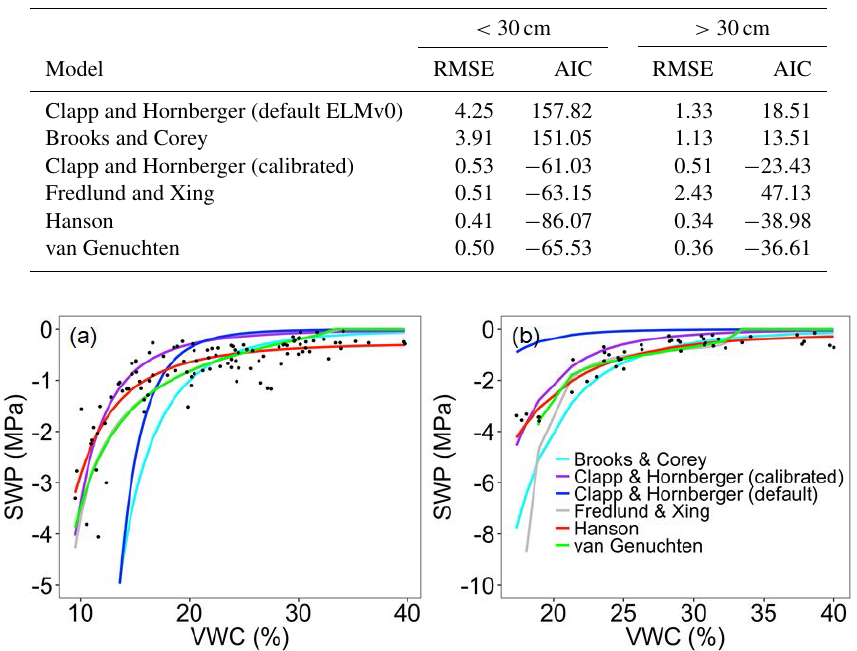
Figure 1. Observed (black dots) and simulated relationship between soil water potential (SWP) and volumetric water content (VWC) by the different models at two soil layers: (a) 0 to 30cm and (b) below